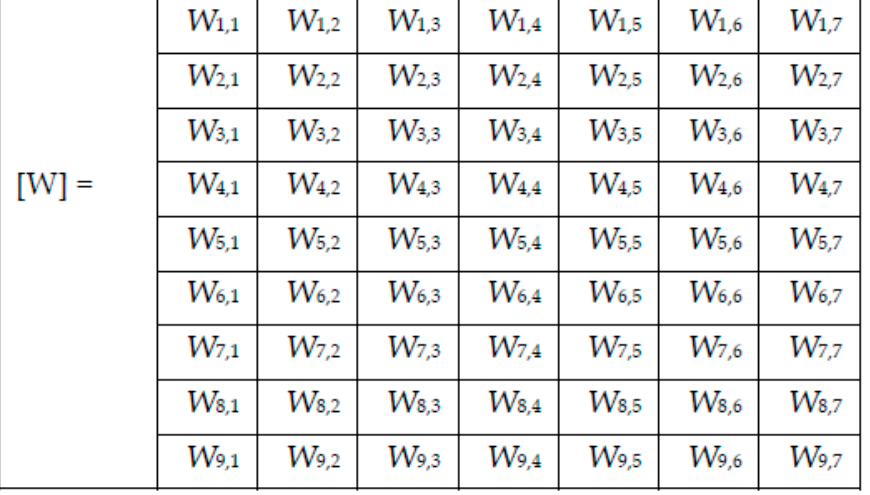
Figure 5. Weight matrix [W].